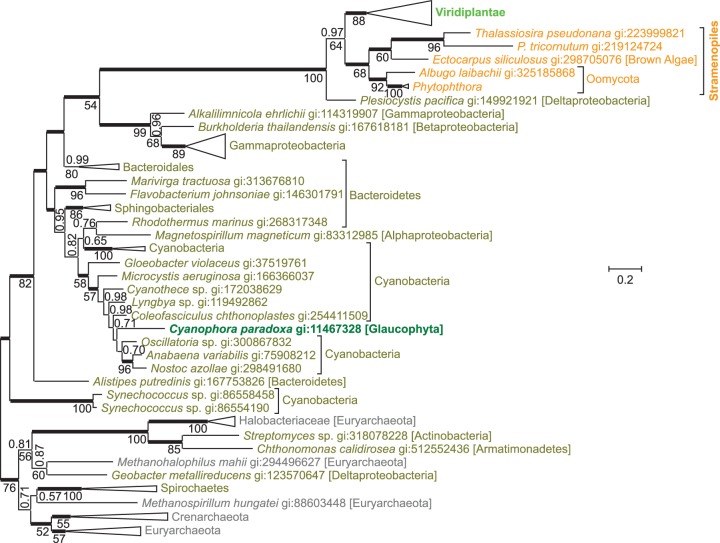
An evolutionary tree for quinolinate synthase indicates separate origins of eukaryotic sequences. The unrooted Bayesian tree shows posterior probabilities above the branches and PhyML bootstrap values below the branches. Thickened horizontal lines represent 1.0 Bayesian posterior probability. Trees with significantly lower log-likelihoods were obtained when monophyly was enforced for all sequences from Eukaryota, from Viridiplantae plus Cyanophora paradoxa, from Bacteria, or from Archaea (supplementary table S1, Supplementary Material online).